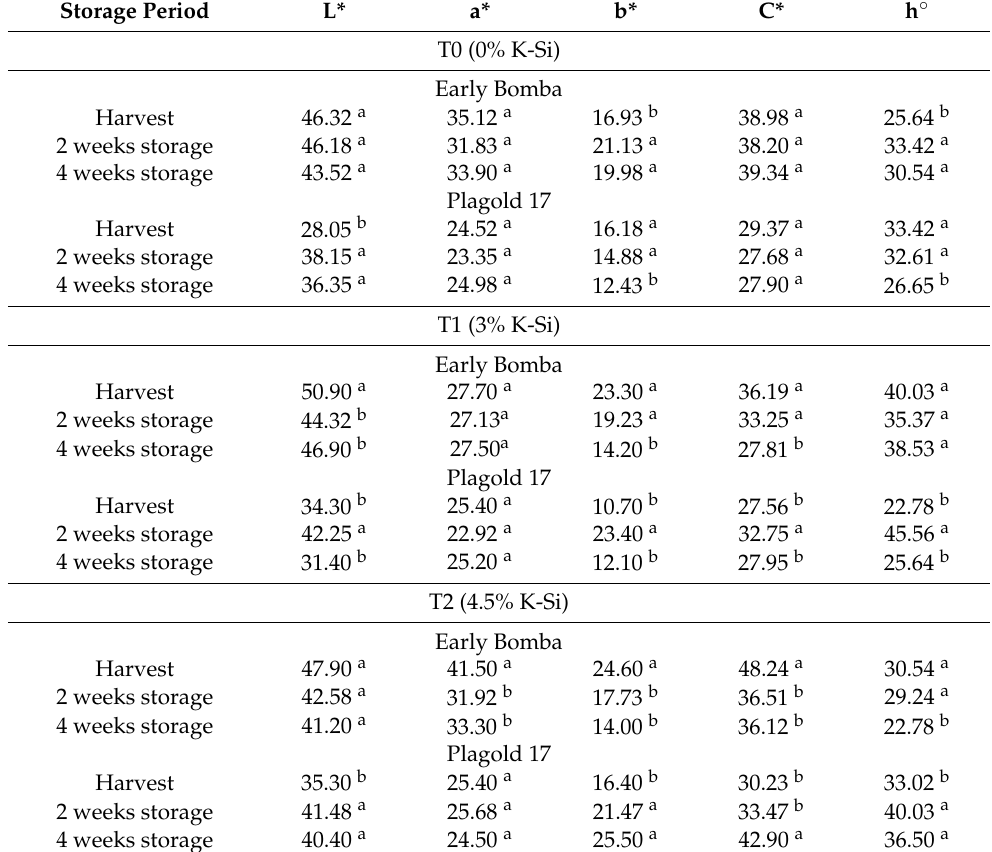
Table 4. Impact of potassium silicon pretreatment and storage period on fruit peel color indices L*, a*, b*, C* and h ◦ of the peach cultivars during harvest and after two cold storage periods (2 and 4 weeks). L* means the brightness of the sample while a * and b * represent the color directions. Values are the means ( n = 5) ± SE. Different letters a, b, indicate difference ( p < 0.05) among storage periods in each treatment for the same